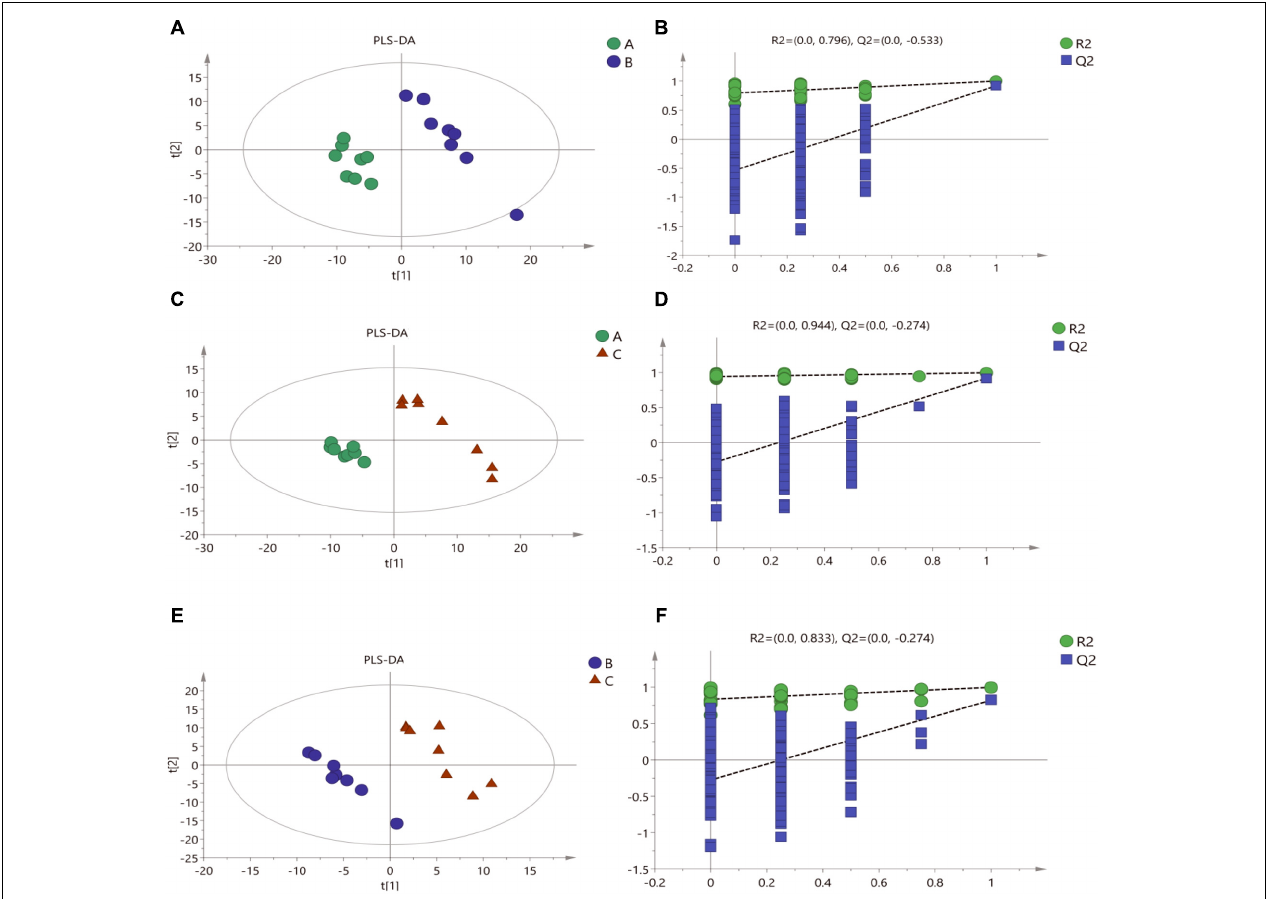
FIGURE 3 | Score plots for extracellular metabolites of GC/MS data. (A) PLS-DA score plots from metabolite profiles for Mycelia A and B samples. (B) A 200 times permutation test of PLS-DA models for (A) . (C) PLS-DA score plots from metabolite profiles for Mycelia A and C samples. (D) A 200 times permutation test of PLS-DA models for (C) . (E) PLS-DA score plots from metabolite profiles for Mycelia B and C samples. (F) A 200 times permutation test of PLS-DA models for (E) .